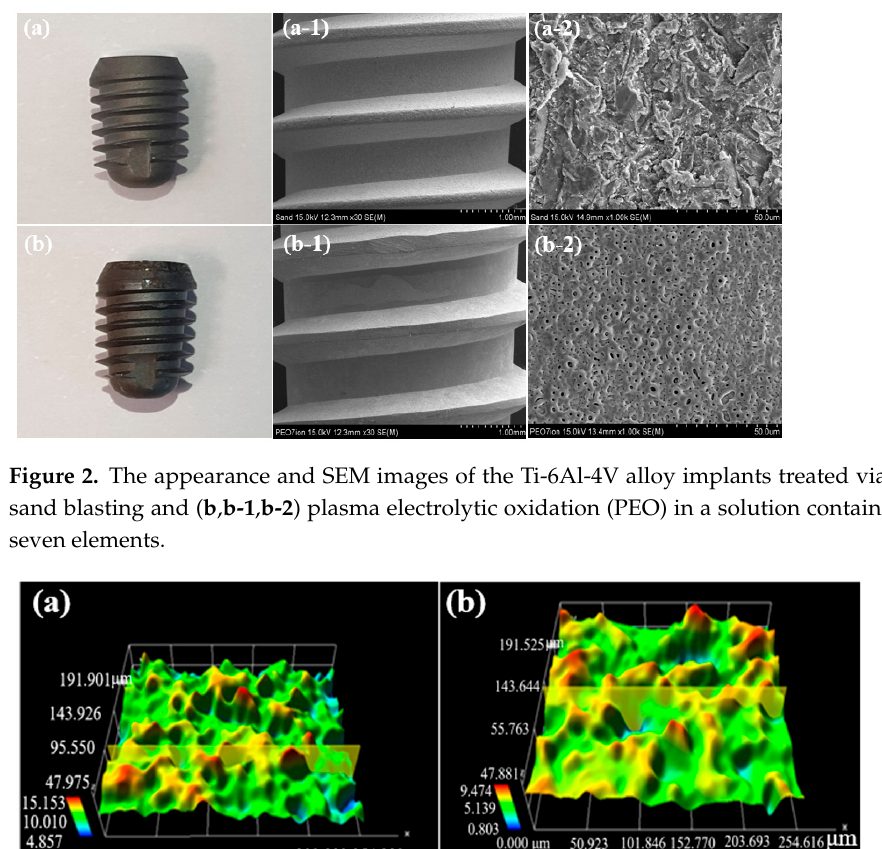
Figure 4. ( a ) Cross-sectional image of the Ti64/7 ion implant; ( b ) EDS area spectrum for the Ti64/7 ion implant. Ca, P, O, Ti, V, Al, Si, Mn, Mg, Sr, and Zn were identified. According to the EDS area results shown in Figure 4b and Table 1, Ca, P, O, Ti, V, Al, Si, Mn, Mg, Sr, and Zn elements were identified . The Ti, Al, and V originated from sub- strate alloy, while the presence of the other elements was attributed to the electrolyte so- lution. In our previous work, we found that anatase, rutile, and HA were the main phases in seven ion implants [24]. The wettability measurements revealed that the surface of Ti64/7 ion implants had a lower contact angle (85.9 ± 8.5) than Ti64/SA implants (99.8 ± 6.8), suggesting that a significant improvement in the hydrophilicity of the Ti-6Al-4V alloy implants was achieved via PEO. The surface energies for Ti64/SA and Ti64/7 ions surfaces were 3.53 ± 0.9 and 4.57 ± 0.5 mJ/m 2 , respectively. In this study, the values of contact angle were somewhat in accordance with those obtained in other works. For example, contact angles in the range between ~ 66.8° and ~ 77.4° and the range between ~76.9° and ~ 82.1° were reported by Pegueroles et al. [26] for the pure titanium implants sanded by either SiC or Al 2 O 3 particles, respectively. Raphel and coworkers [27] measured the values of contact angles of Ti-6Al-4V substrates irradiated with UV light in the presence of phos- phate-buffered saline. This UV exposure resulted in a significant increase in surface hy- drophilicity, with the contact angle decreasing from 50.83° to 26.33°, consistent with an increase in surface hydroxyls. On the other hand, lower values of contact angle below 15° were reported by Li et al. [28] for pure titanium treated via PEO in tetraborate electrolytes. As for surface energy, Kaseem and Choe [23] reported recently higher surface energies (~7.44 and ~8.13 mJ/m 2 ) than those obtained in the present work for Ti-6Al-4V alloy treated via PEO in solutions containing Zn and Mg ions. Higher surface energy values in the